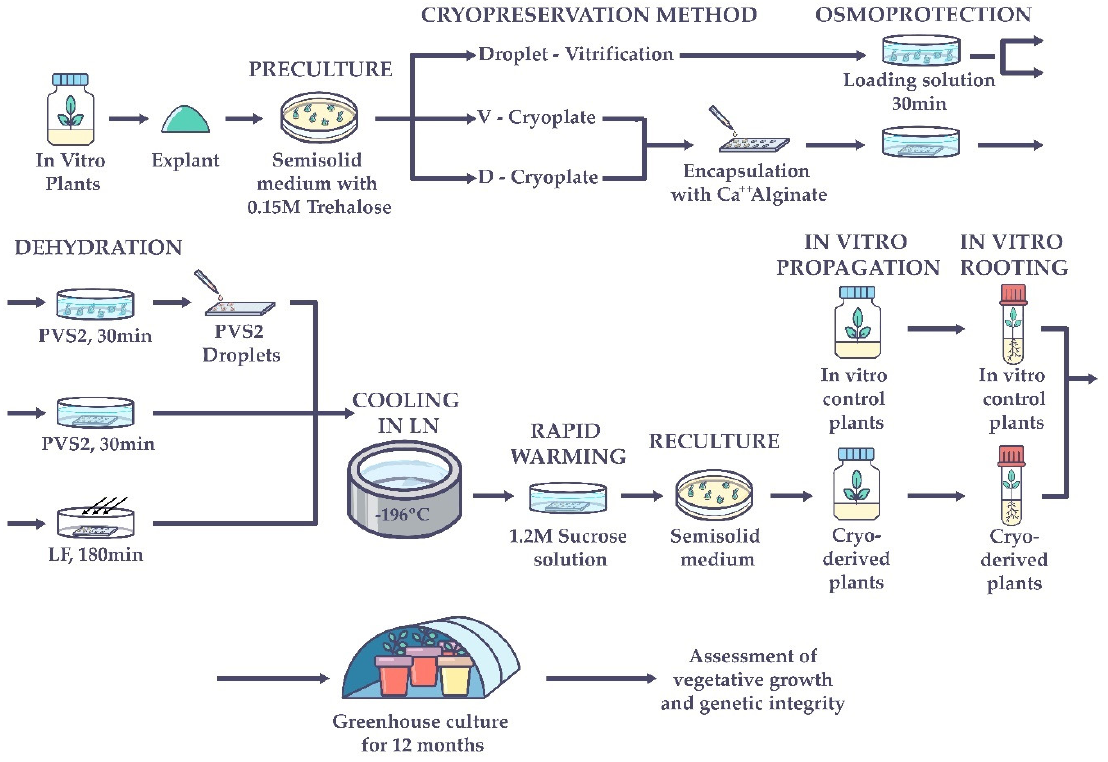
Figure 4. Graphic representation of the experimental work for assessment of vegetative growth and the genetic integrity of Vanilla planifolia regenerants after cryopreservation. PVS2: Plant vitrification solution 2. LF: Laminar flow. LN: Liquid nitrogen.